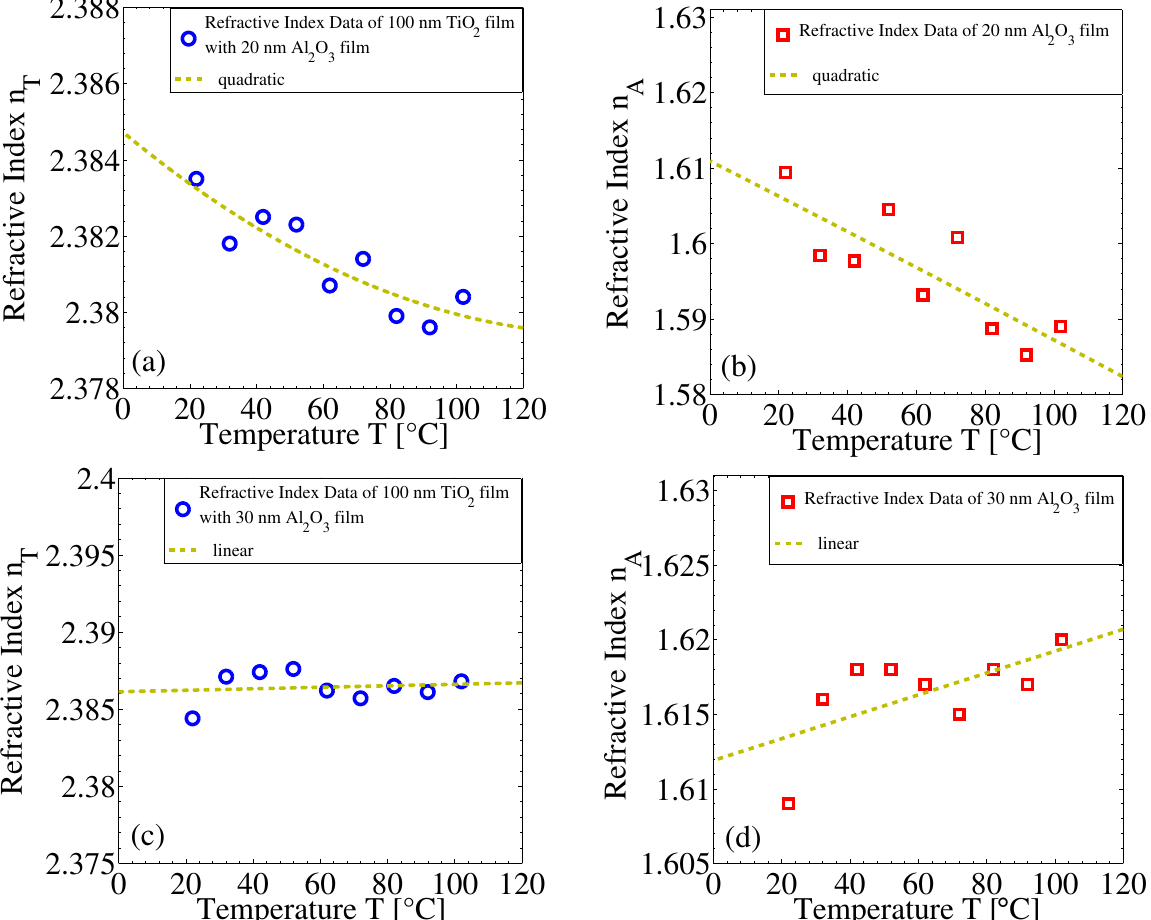
Figure 5. Temperature dependence of the refractive index of ALD-TiO films in bilayers: ( a ) for a 100 nm-thick TiO barrier layer; ( b ) for a 20-nm Al a 30-nm Al O diffusion barrier layer; and ( d ) for a 30-nm Al 2 3